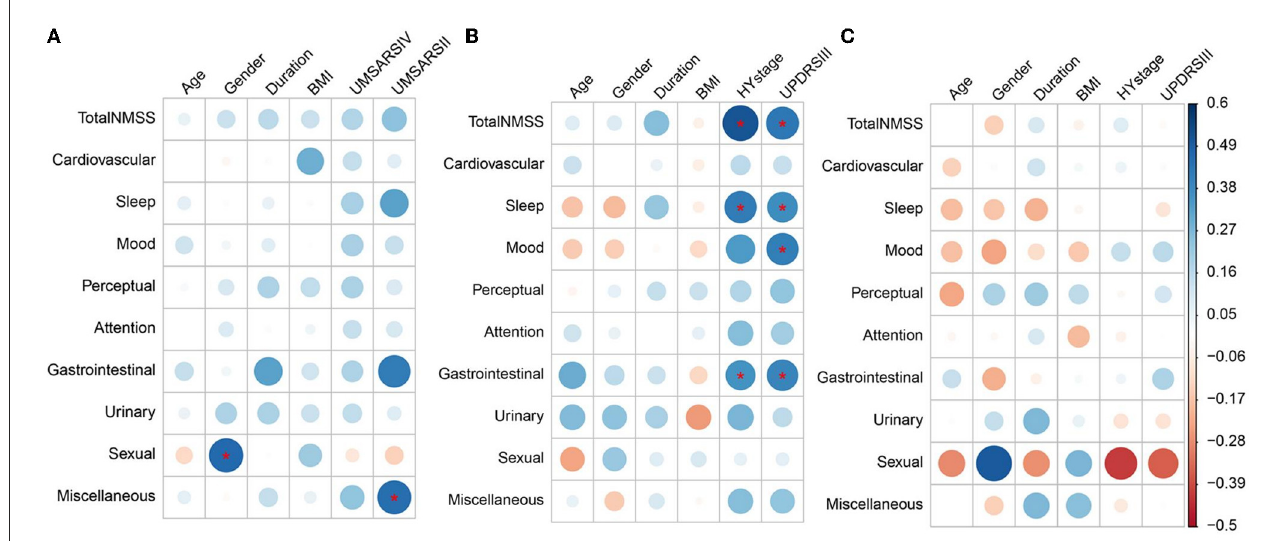
FIGURE2 Heatmap of non-motor symptoms correlation with other clinical features in MSA, PD, and PSP. (A–C) Correspond to the left, middle, and right parts of the graph, respectively, and represent the correlations of non-motor symptoms with clinical features in MSA, PD, and PSP, respectively. (A) Sexual dysfunction subdomain scores in MSA were positively correlated with the male gender. Miscellaneous subdomain scores of MSA were positively correlated with UMSAR-II scores in MSA. (B) Total NMSS scores, sleep/fatigue, and gastrointestinal subdomain scores of PD were positively correlated with H&Y stage. Total NMSS scores, sleep/fatigue, mood/apathy, and gastrointestinal subdomain scores of PD were positively correlated with UPDRS-III. (C) No significant correlations were found between the total and all subdomain scores of the NMSS of PSP with age, gender, disease duration, BMI, H&Y stages, and UPDRS-III scores. Blue and red colors in each figure represented positive or negative correlations between non-motor symptoms and the clinical features, respectively. The colors in the ribbon on the right indicate the magnitude of the correlations, the same color represents the same correlation coefficient in the whole graph. *Statistically significant correlations after Bonferroni’s correction (10 NMS parameters, 6 clinical features parameters; adjusted significance level at p < 0.00083). MSA, multiple system atrophy; PD, Parkinson’s disease; PSP, progressive supranuclear palsy; UMSARS-IV, the unified multiple system atrophy rating scale, Part IV; UMSARS-II, the unified multiple system atrophy rating scale, Part II; H&Y stage, Hoehn and Yahr stage; UPDRS-III, movement disorders society–revised unified Parkinson’s disease rating scale, Part III; NMSS, the non-motor symptom scale; NMS, non-motor symptoms.